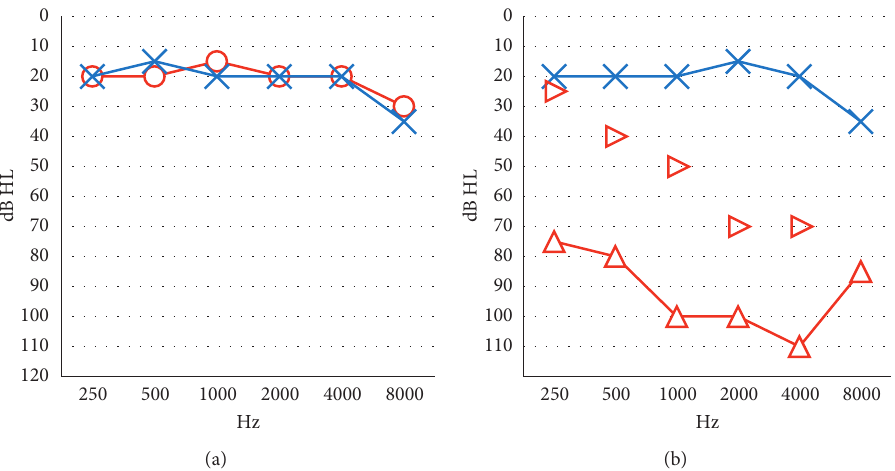
Figure 1: Audiometric threshold before (a) and after (b) the surgical treatment. Red circles and lines: right ear air threshold, red triangles and lines: masked right ear air threshold, red triangles: right ear bone threshold, and blue crosses and lines: left ear air